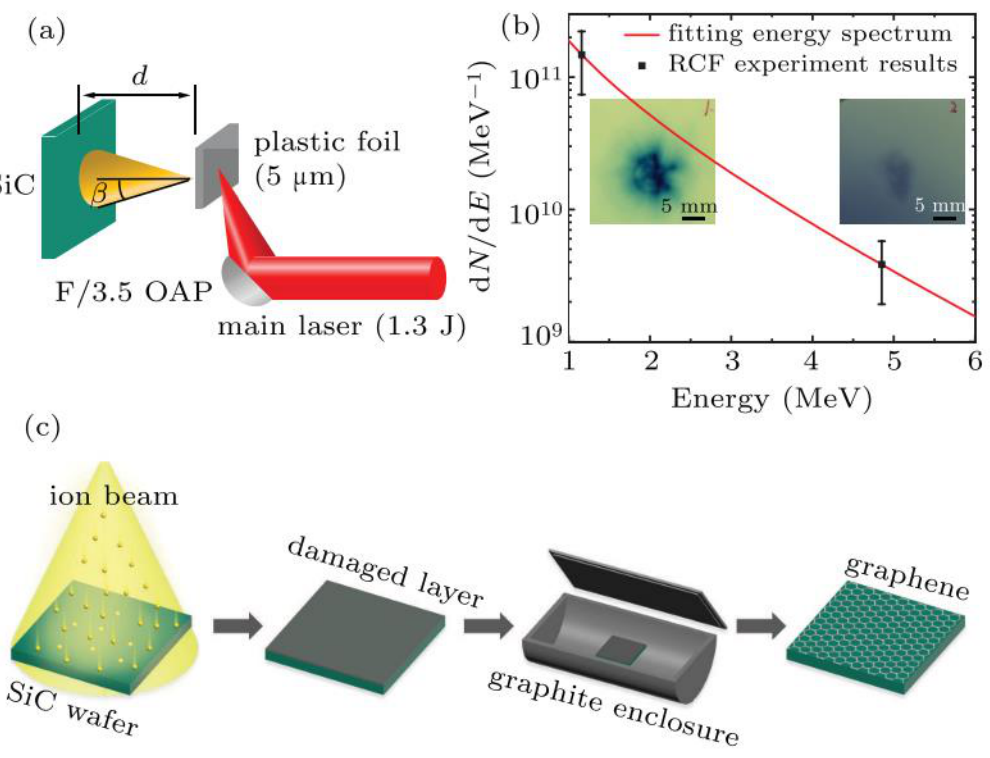
Figure 11. ( a ) Schematic diagram of the experiment setup. ( b ) The laser-accelerated proton beam energy spectrum measured with the RCF stack detector. ( c ) Schematic diagram of graphene preparation after laser-accelerated ion beam irradiation and annealing.